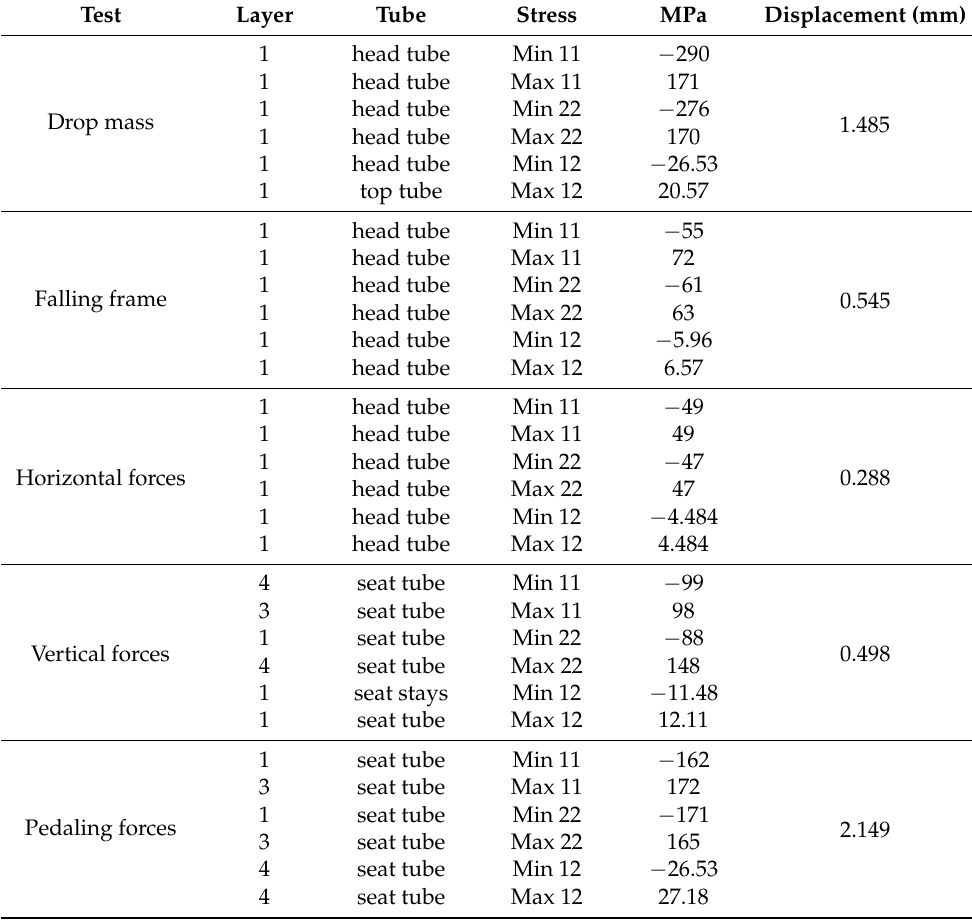
Table 18. Stress and displacement results of T300 Woven quasi-isotropic